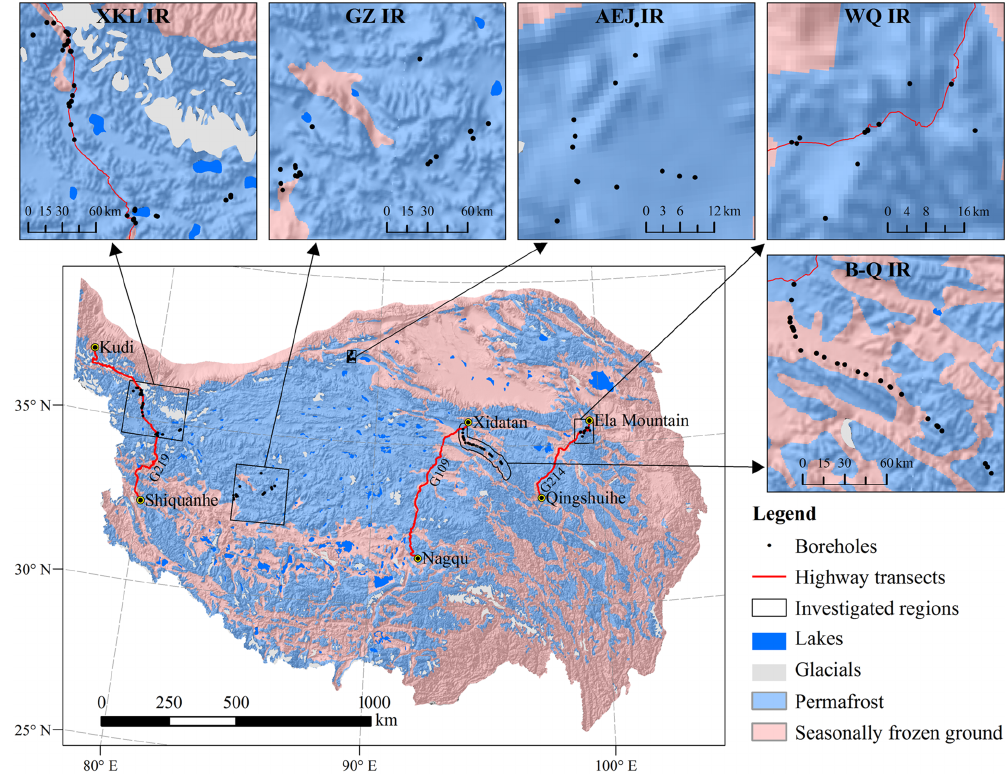
Figure 1. Spatial distribution of the field survey regions of the Tibetan Plateau (based on the permafrost distribution map made in